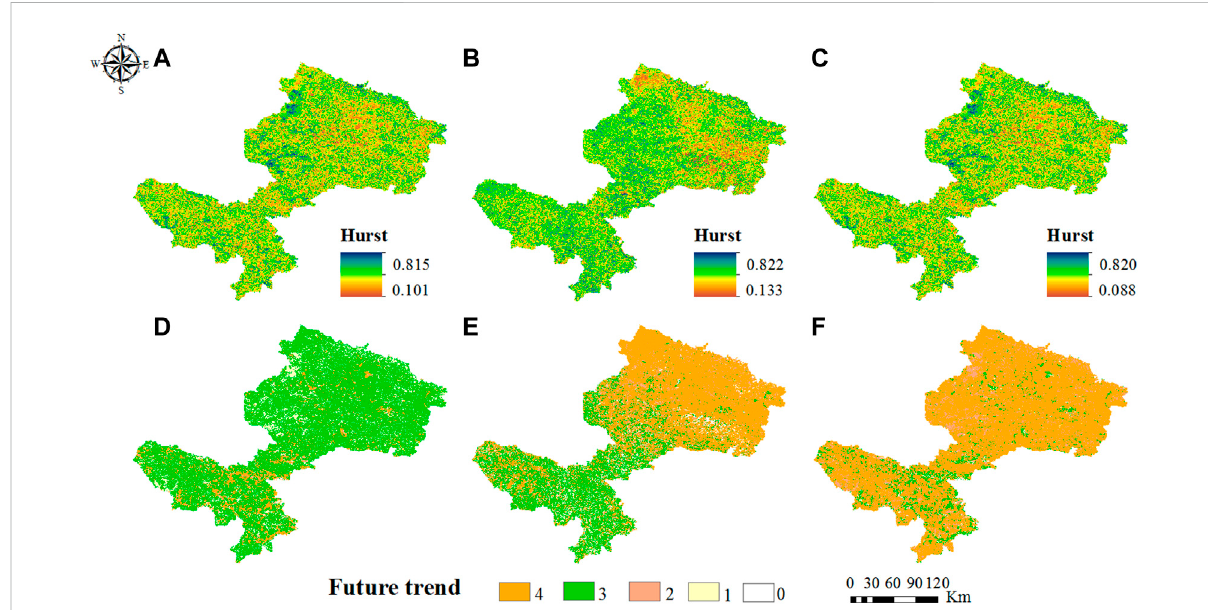
FIGURE 8 SpatialdistributionoftheH-valueandfuturetrend: (A) H-valueofSWC, (B) H- valueofEC, (C) H-value ofpH, (D) futuretrendofSWC, (E) future trend of EC, and (F) future trend of pH. Note: 0 – 4 represent not signi fi cant, persistence and increase, persistence and decrease, from increase to decrease, and from decrease to increase, respectively.